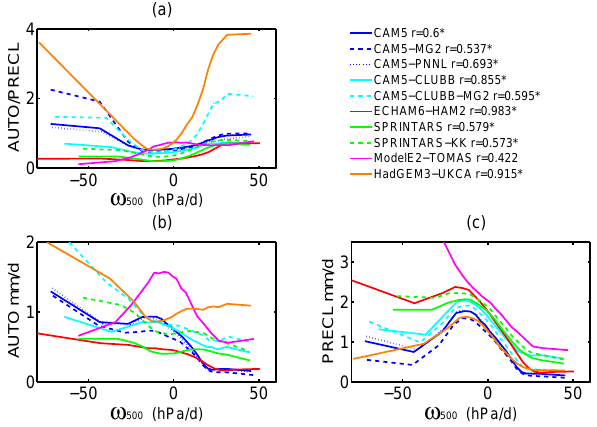
Figure 6. Same as Fig. 1, but for (b) column-integrated autocon- version rate (AUTO), (c) the large-scale surface precipitation rate (PRECL) and (a) their ratio AUTO/PRECL from the 9 GCM simu- lations. The number marked in each simulation is the corresponding correlation coefficient between AUTO/PRECL and λ and number with mark “*” indicates the correlation is significant (at 95% con-